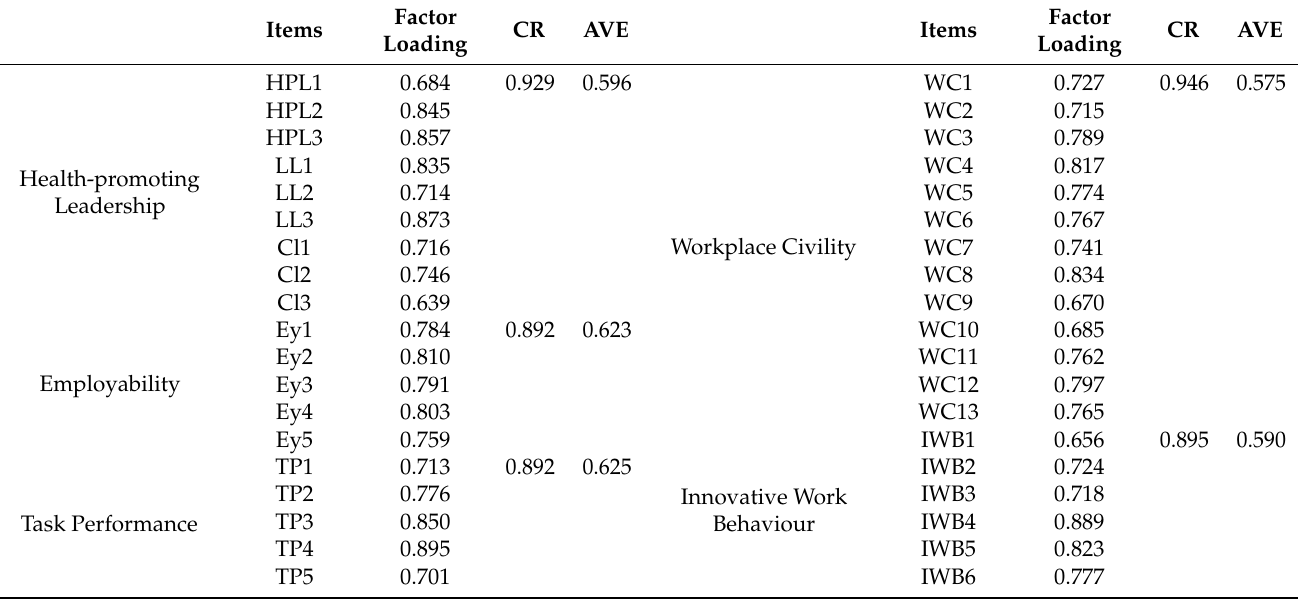
Table 2. Confirmatory factor analysis